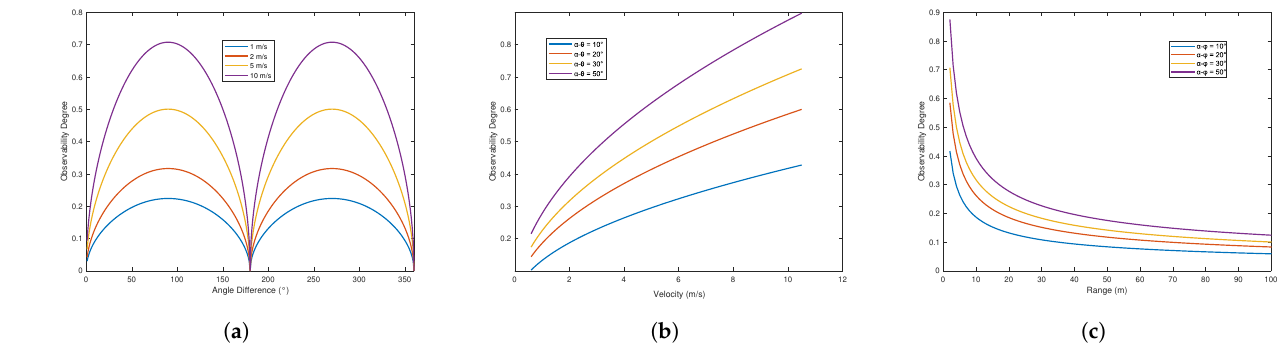
Figure 2. The relationships between different parameters and observability degree. ( a ) Relationship between heading angle and observability degree. ( b ) Relationship between velocity and observability degree. ( c ) Relationship between ranging and observability